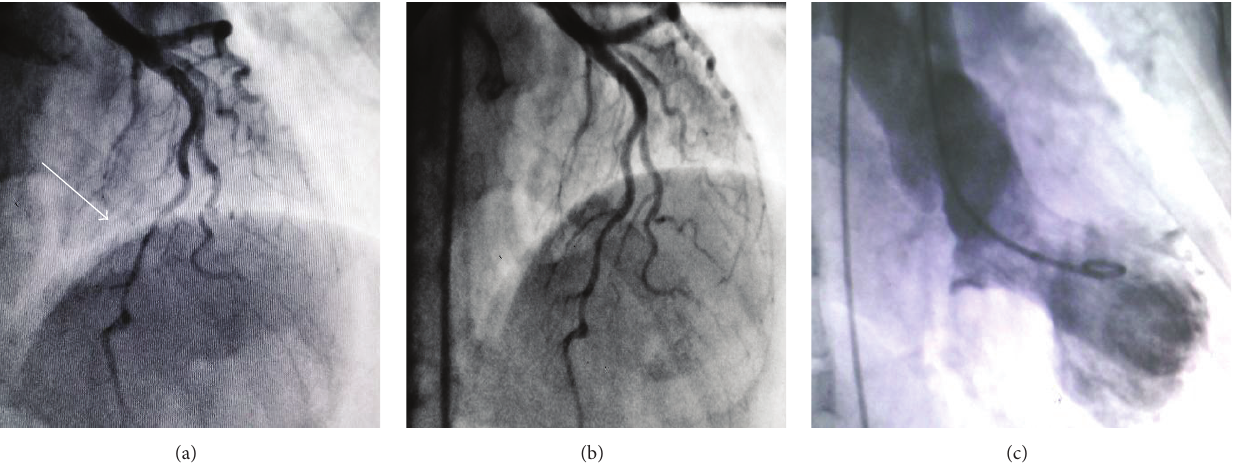
Figure3:Coronaryangiographyrevealedseveremusclebridgeatmidportionofleftanteriordescendingarteryduringsystole(a)anddiastole (b). Left ventriculography showed systolic ballooning of the apex consistent with Takotsubo cardiomyopathy (c).